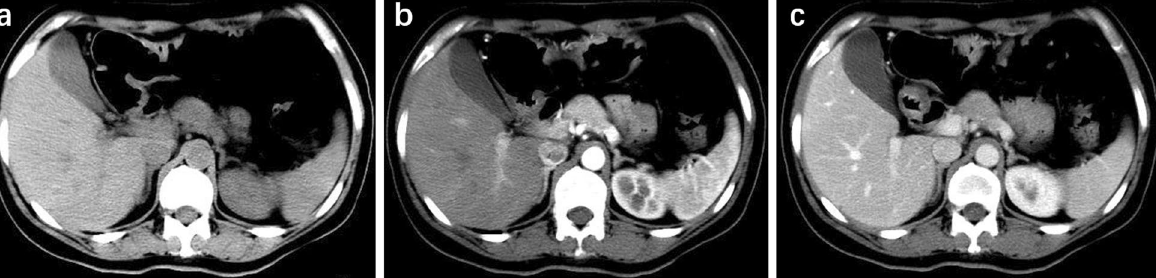
Fig. 2 MiNEN of the pancreatic neck in a 48-year-old woman . a Unenhanced CT scan shows an ill-defined mass. The CT value of the tumor is 42 HU. b Arterial phase CT scan shows diffusely moderate homogeneous enhancement of the purely solid lesion with a size of 2.5 cm. The CT value of the tumor is 81 HU. c Portal phase CT scan shows washout of the oval tumor. The CT value of the tumor is 66